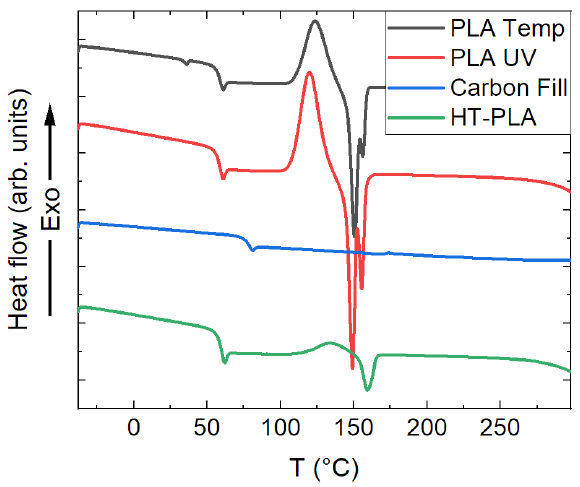
Figure 14. Differential scanning calorimetry (DSC) measurements of filled PLA materials.